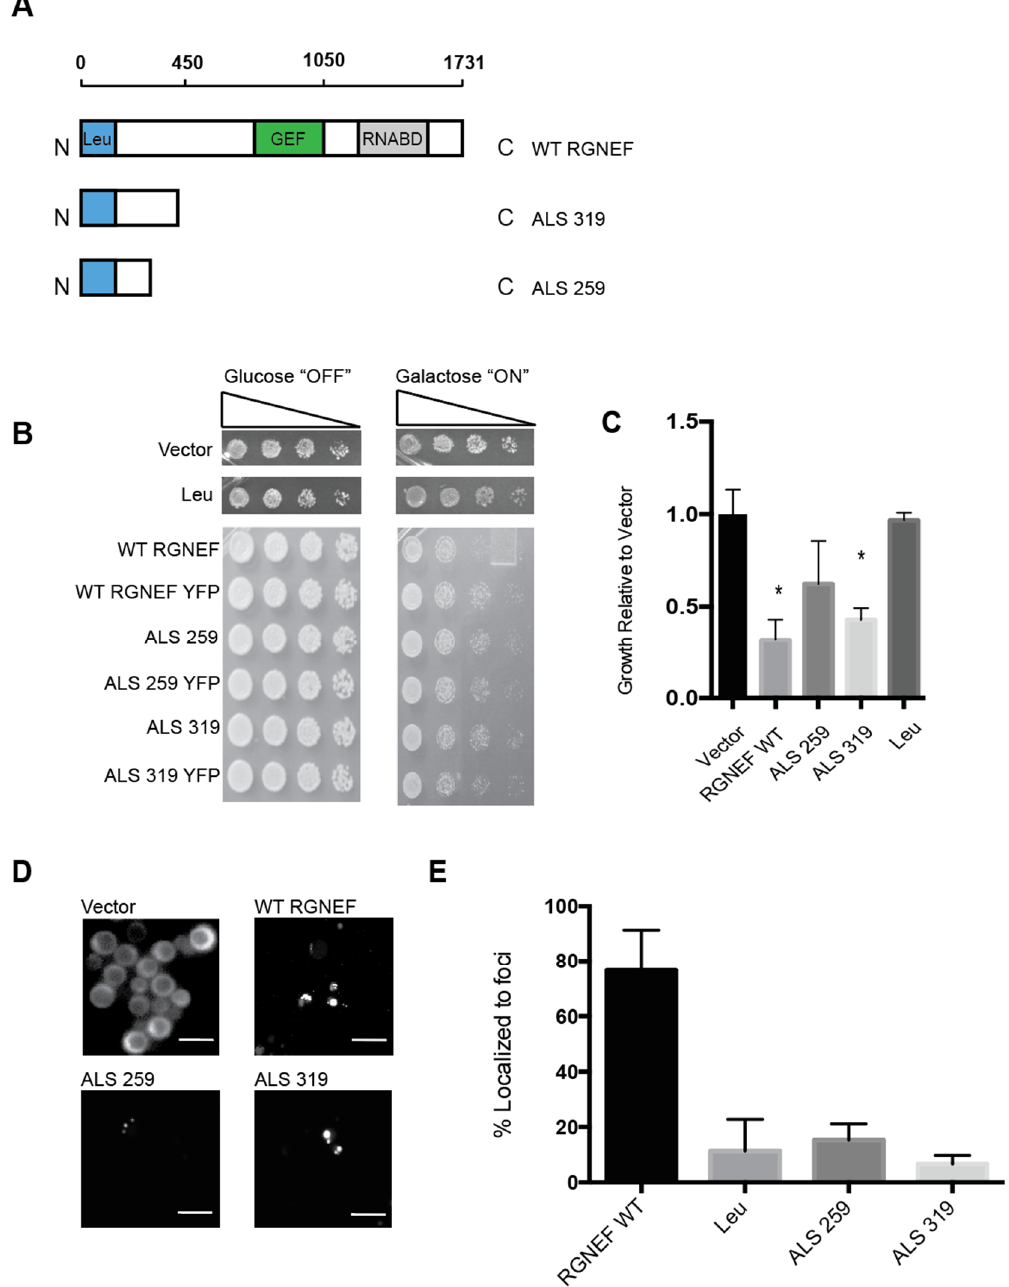
Figure 3. Yeast model of predicted amyotrophic lateral sclerosis (ALS)-associated RGNEF variants. ( A ) Schematic presentation of full length wild type RGNEF and truncated ALS-associated constructs. The truncations are named according to their predicted amino acids lengths. ( B ) Yeast growth assay of RGNEF WT and predicted truncations. ( C ) Quantification of data as shown in B. * indicates statistical significance ( p < 0.05). ( D ) Localization predicted ALS-associated RGNEF variants fused to YFP by fluorescence microscopy. The scale bar corresponds to 10 µ m. ( E ) Quantification of the fluorescent microscopy as show in D as percentages of cells containing fluorescent foci. Error bars represent standard deviations.